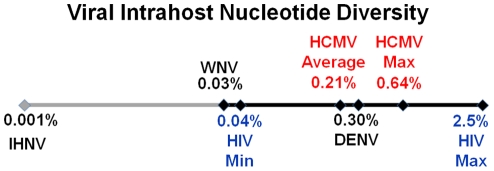
HCMV intrahost diversity is similar to RNA viruses.A logarithmic number line plotting nucleotide diversity for representative RNA viruses is shown. West Nile virus (WNV), dengue virus (DENV) and human immunodeficiency virus (HIV) were chosen because they exhibit low, mid, and high levels of π, respectively, for RNA viruses. The HIV values are from a whole genome sequencing study of 12 samples [47], and the minimum (HIV Min) and maximum (HIV Max) values are shown. HCMV Average is the genome wide average across patients for π and HCMV Max is the maximum ORF value obtained from Illumina sequencing. See Table S4 for a more thorough list of nucleotide diversity values for RNA virus populations.